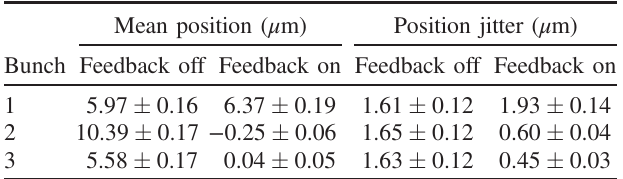
TABLE II. Mean beam position and beam jitter measured at P3 with feedback off and on for bunches 1, 2, and 3. Standard errors are given for both the mean positions and